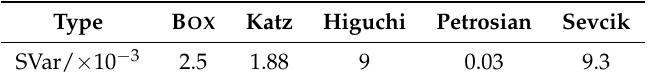
Table 1. Robustness evaluation (SVar, zero-center normalized statistical